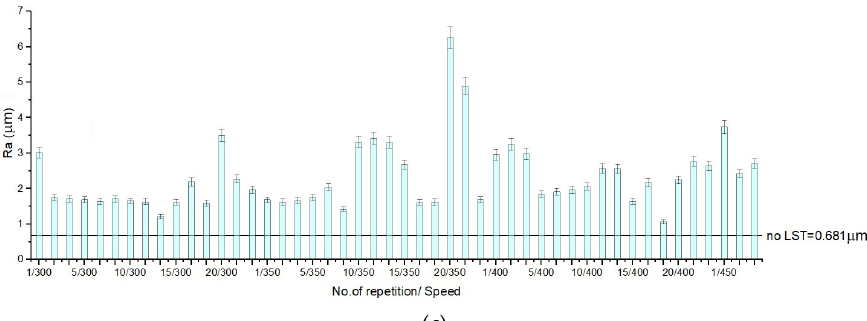
Figure 8. Surface roughness charts for design type A, R z —deviation from the mean line, specifically focusing on the highest peak and valley ( a ), R t —total height of the roughness profile of the deepest valley within the evaluation length ( b ) and R a —measures the average length between the peaks and valleys and the deviation from the mean line on the entire surface ( c ).